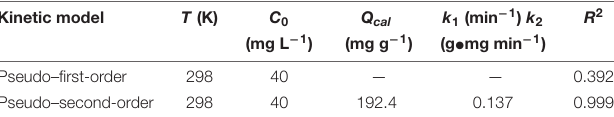
TABLE 1 | Kinetic parameters of different models for uranium (VI) adsorption on TiO 2 /Ti (temperature 298 K, pH 5.0, mixing time 60 min, and amount of TiO 2 /Ti 0.025 g).